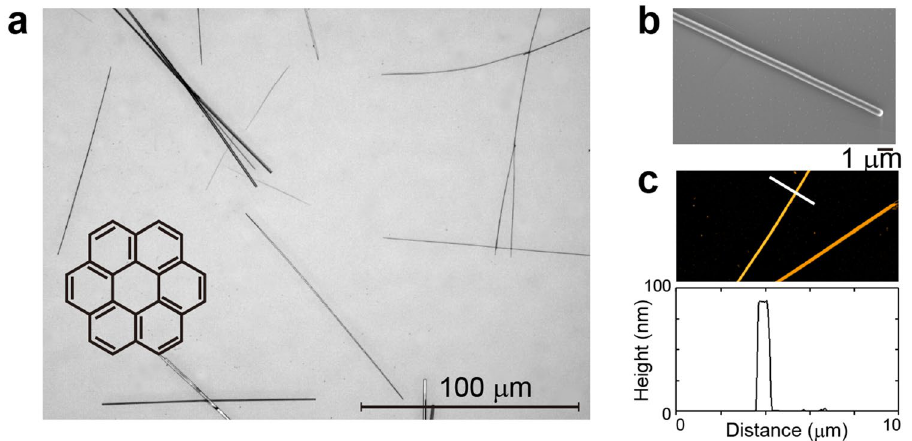
Figure 1. Morphology of coronene nanofibers. (a) Optical micrograph of coronene nanofibers on substrate. Inset: chemical structure of coronene. ( b) SEM image of a coronene nanofiber. ( c) Upper panel: AFM image of coronene nanofibers. Lower panel: cross section of the nanofiber along the white line in the upper